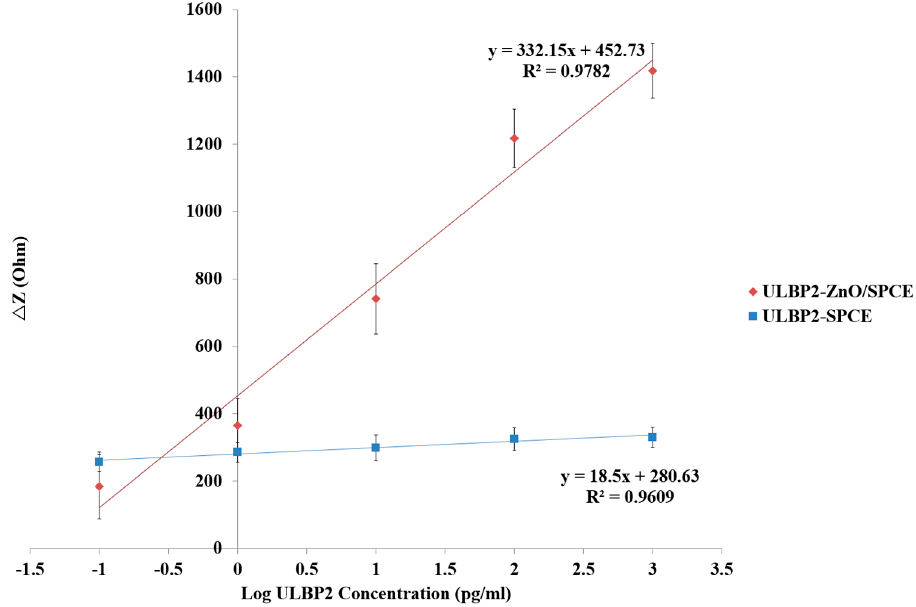
Figure 9. The fitting equations for the transfer characteristics of the ULBP2-SPCE and ULBP2-ZnO / SPCE immunosensors determined at their optimal measurement frequencies (ULBP2-SPCE: 8.37 kHz; ULBP2-ZnO/SPCE: 5.92 MHz).